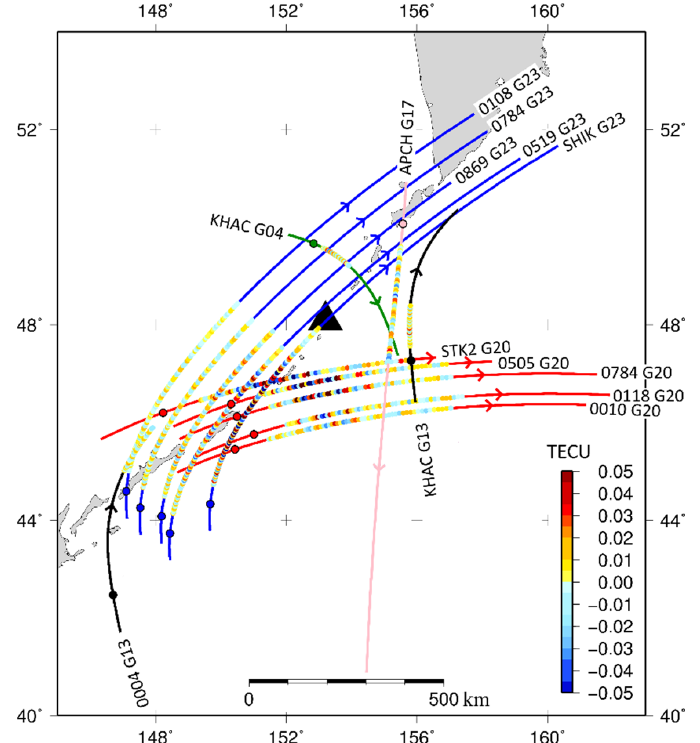
Figure 2. The map of TEC measurements performed during 18:30–21:00 UT on 14 June 2009. Color lines with arrows indicate trajectories of ionospheric piercing points (IPPs). Dots show the IPPs locations at 18:51 UT, i.e., time of the explosion. Observation site name and GPS satellite number are shown near each track. Amplitudes of the most intense TEC disturbances detected by the appropriate site-satellite pairs are plotted by colored dots along each curve. The volcano location is shown by the black triangle.